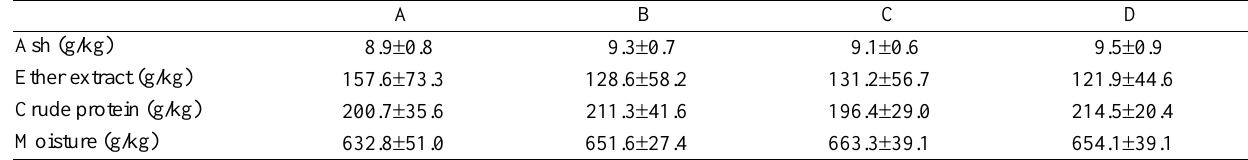
Table 4. Effect of dietary carob pods on the chemical composition of the 13th rib steak of the pigs (Mean 